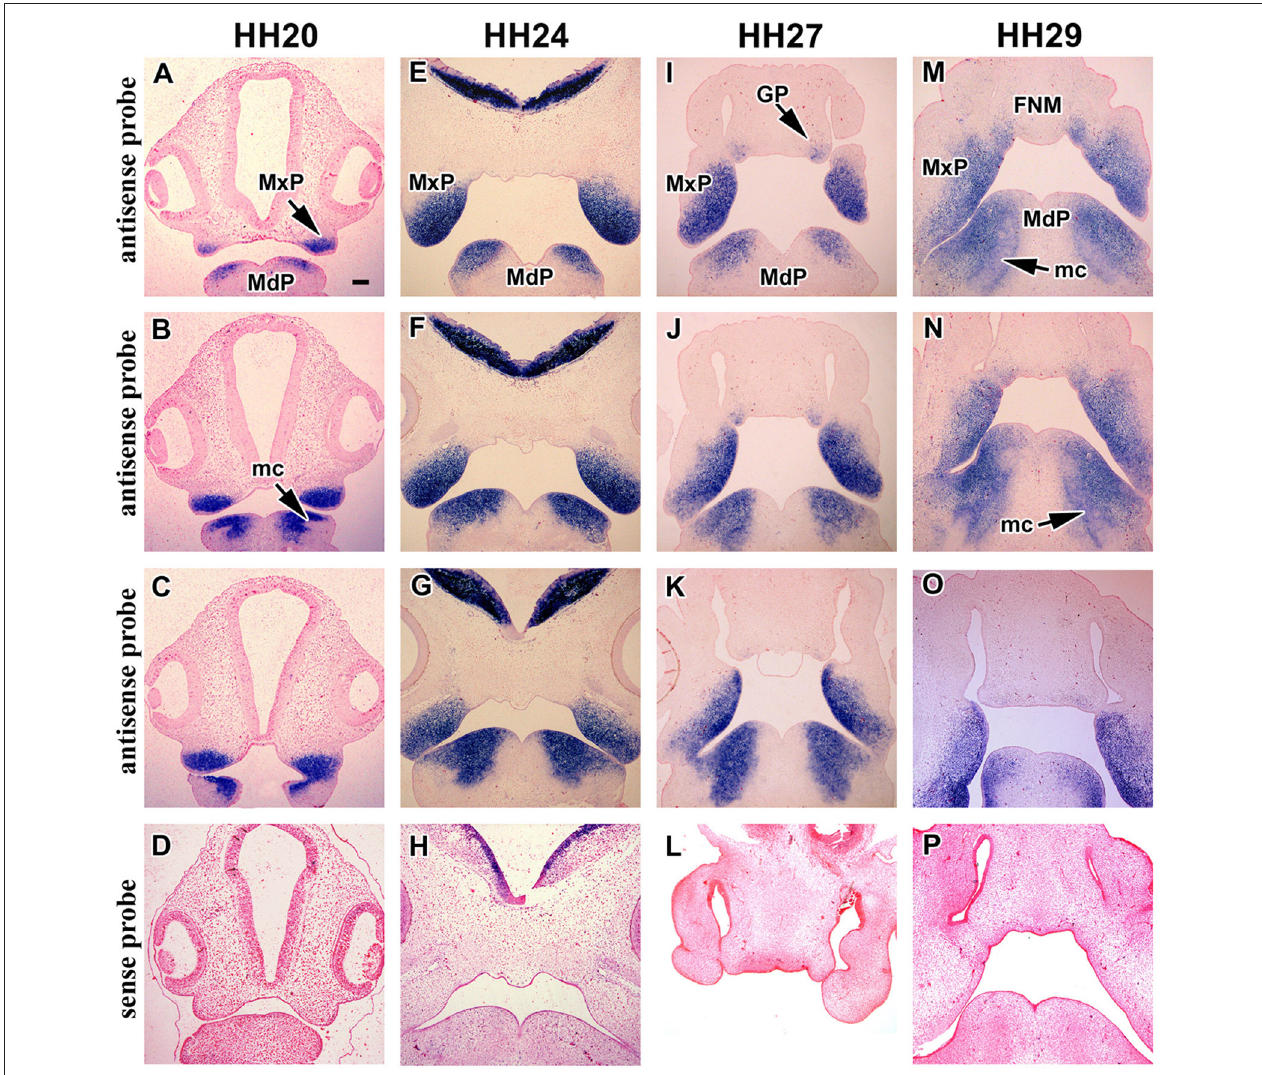
FIGURE 3 | Gene expression of MORN5 in later stages of chicken embryo. (A–C) ISH analysis in frontal sections of chicken head at stage HH20. There was strong expression in the maxillary prominence. The expression appeared in the cranial part in each mandibular prominence and it continued in dorsal direction. (B) No expression was observed in mesenchymal condensations and close to the fusion region of mandibular prominences. (E–G) MORN5 expression in frontal section of chicken head at stage HH24. MORN5 expression was strong in the mesenchyme of maxillary prominences. MORN5 expression was localized in the dorsal part of mandibular prominence, but not in mesenchymal condensation and close to the midline. (I–K) Frontal sections of chicken head at stage HH27 showed prominent expression in the maxillary prominence. There was weak expression in the globular process. Prominent expression was observed in rostral part of maxillary prominence and also in the mandibular prominence with the exception of midline. (M–O) Frontal sections of chicken head at stage 29 where beak is evident. MORN5 expression was localized in rostral part of maxilla and in fusion region. In the mandibular prominence, there was strong expression but not in the midline. (D,H,L,P) ISH analysis using sense probe. FNM, frontonasal mass; GP, globular process; mc, mesenchymal condensation; MdP, mandibular prominence; MxP, maxillary prominence. Scale bars = 100 µ m.